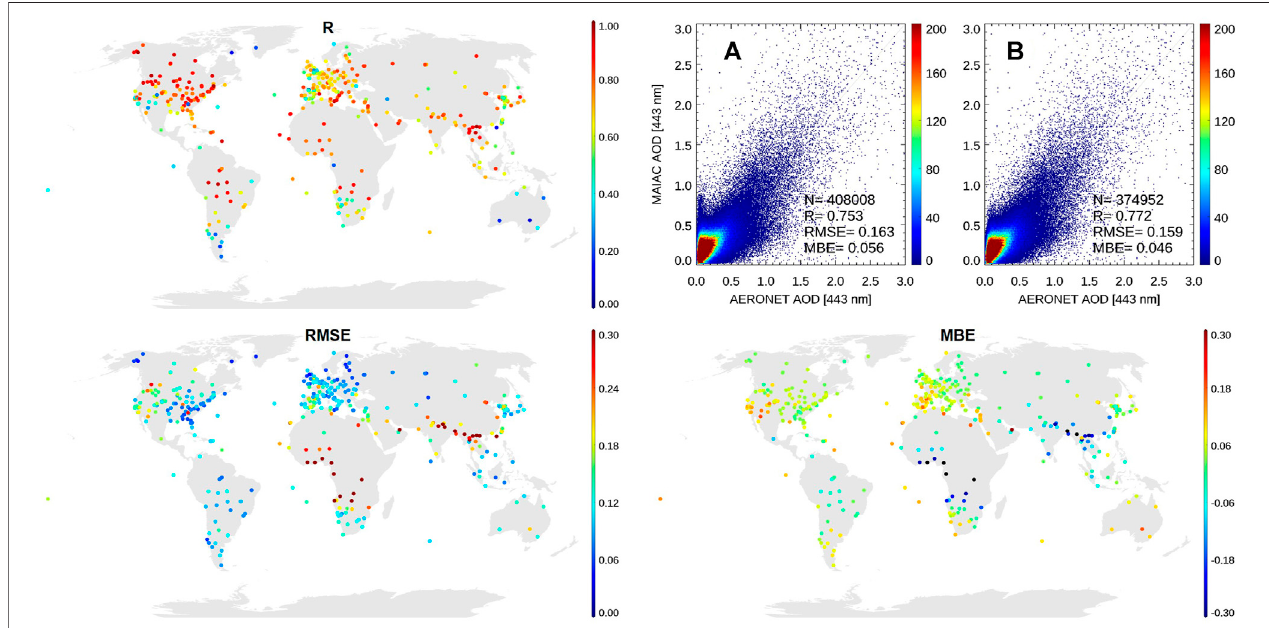
FIGURE 2 | Global AERONET validation of MAIAC EPIC AOD at 443 nm. The geographic distribution of the site-level results is displayed for the regression coef fi cient (R), root mean square error (RMSE) and the mean bias error (MBE). The two scatterplots show the summary validation using all AERONET sites (A) and its subset with 12 bright sites (see Aeronet AOD Validation )